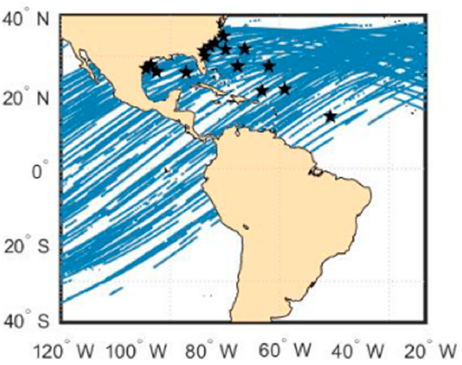
Figure 12. Distribution of mirror point trajectories for buoy stations and CYGNSS observations.